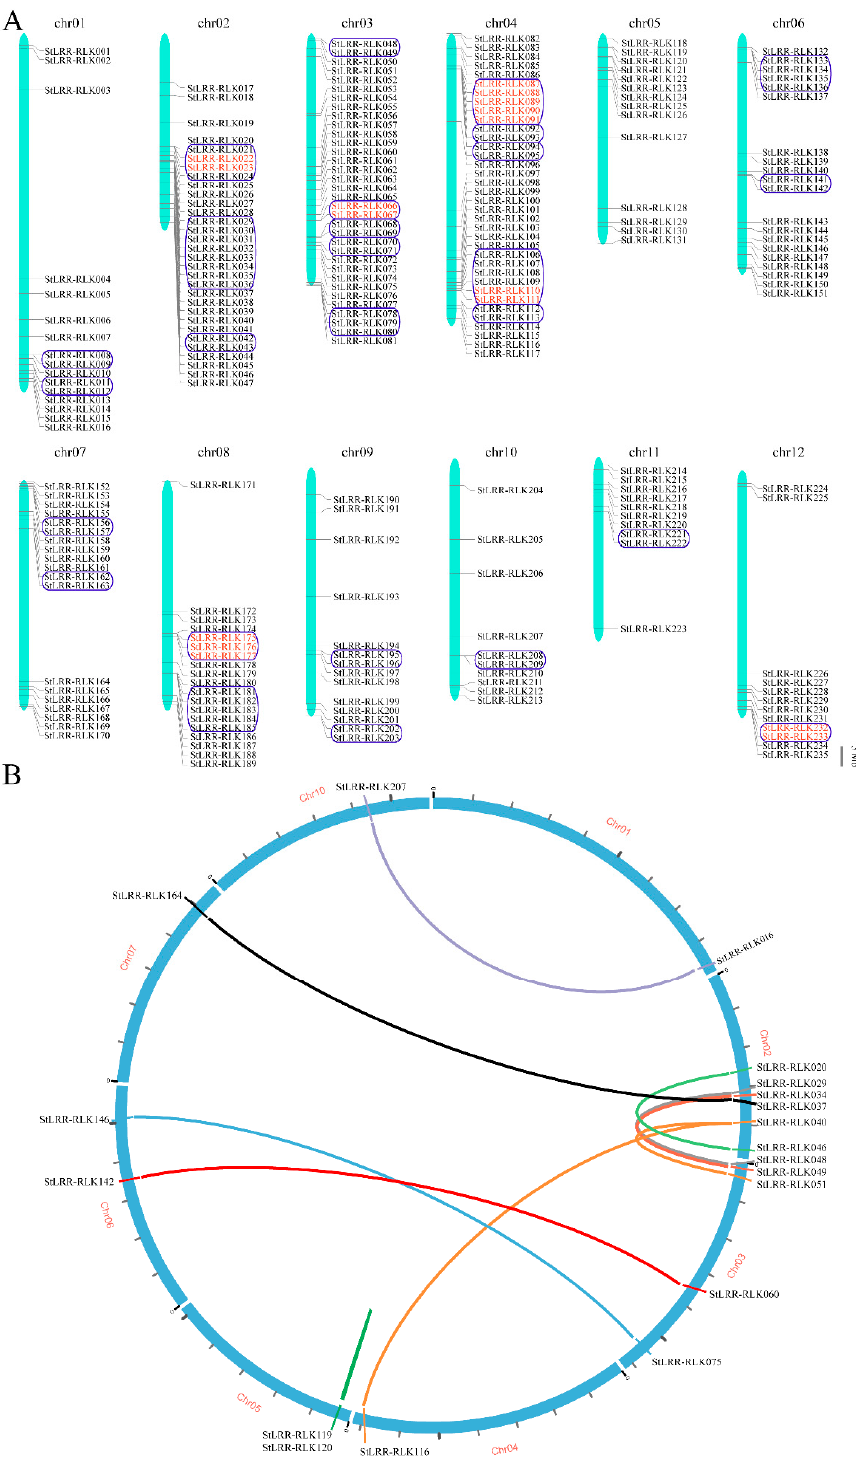
Figure 4. Chromosome distribution and duplication analysis of the potato LRR-RLK genes. ( A ) 235 StLRR-RLK genes were mapped to 12 potato chromosomes. The blue box indicated a gene cluster and the tandem duplication is indicated by red colored names; ( B ) The 10 putative segmental duplication pairs are linked by the colored lines respectively.